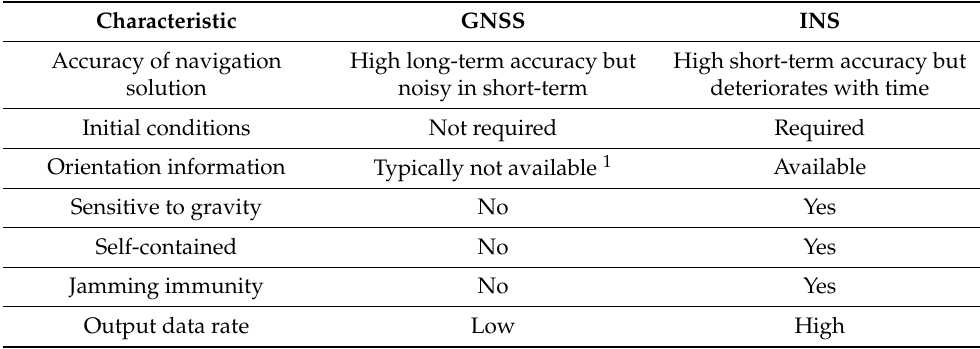
Table 1. Summary of GNSS and INS characteristics (Source: